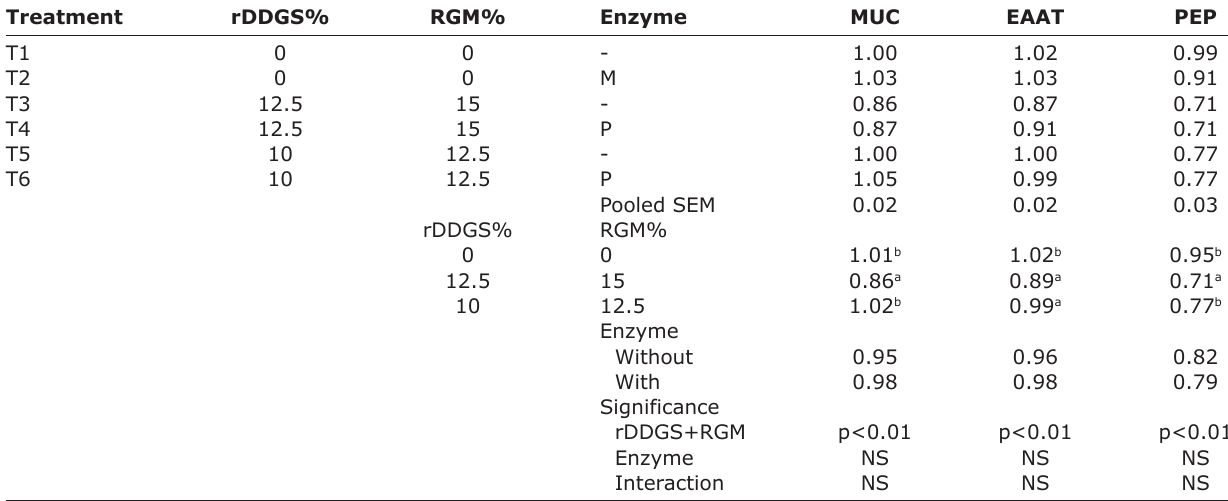
Values bearing different superscripts within the column differ significantly. NS=Non-significant (p>0.05), M=Multienzymes, P-Protease, rDDGS=Rice based distillers dried grains with solubles, RGM=Rice gluten meal Table-3: Effect of feeding different level of rDDGS and RGM combinations on gene expression (relative fold expression).